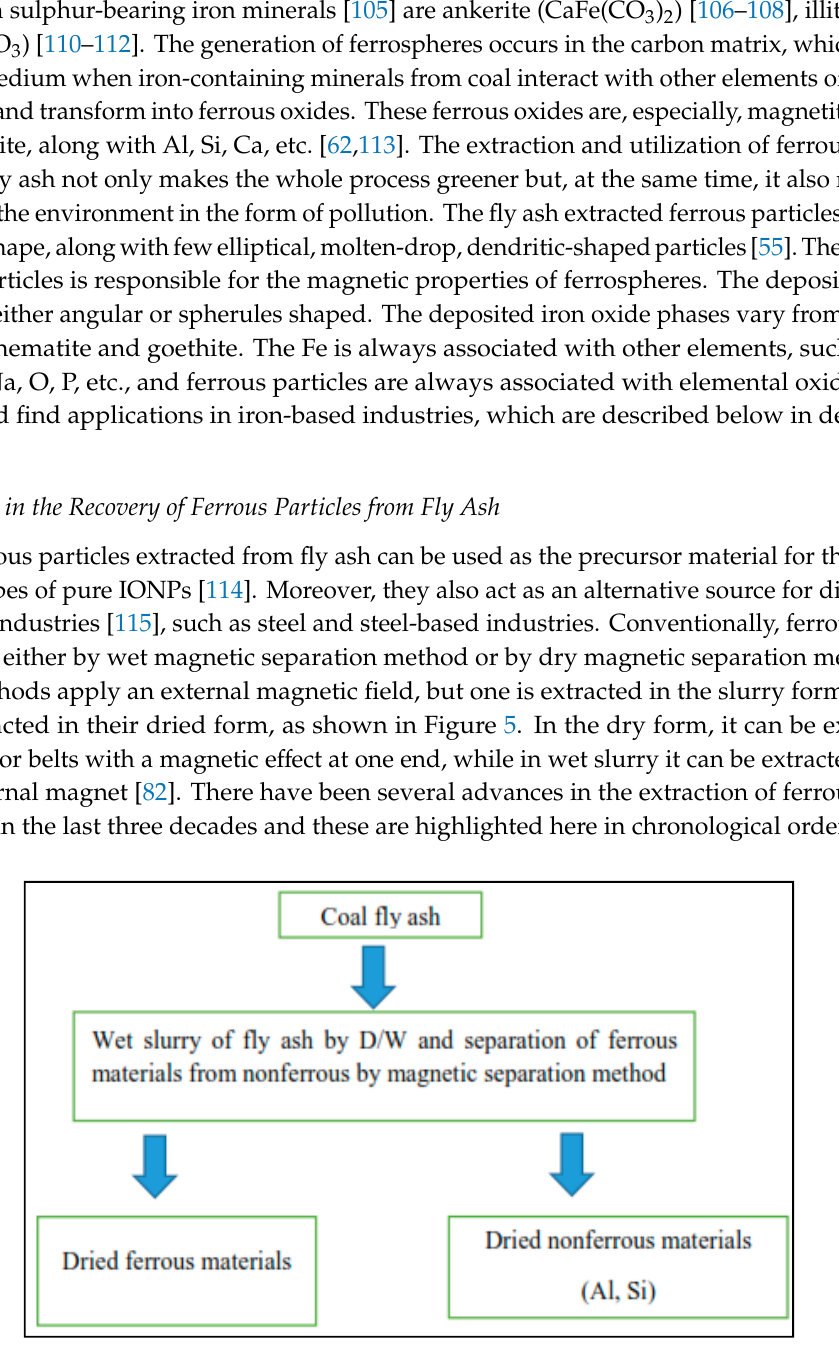
Figure 5. Schematic diagram for magnetic separation of fly ash ferrous fractions.